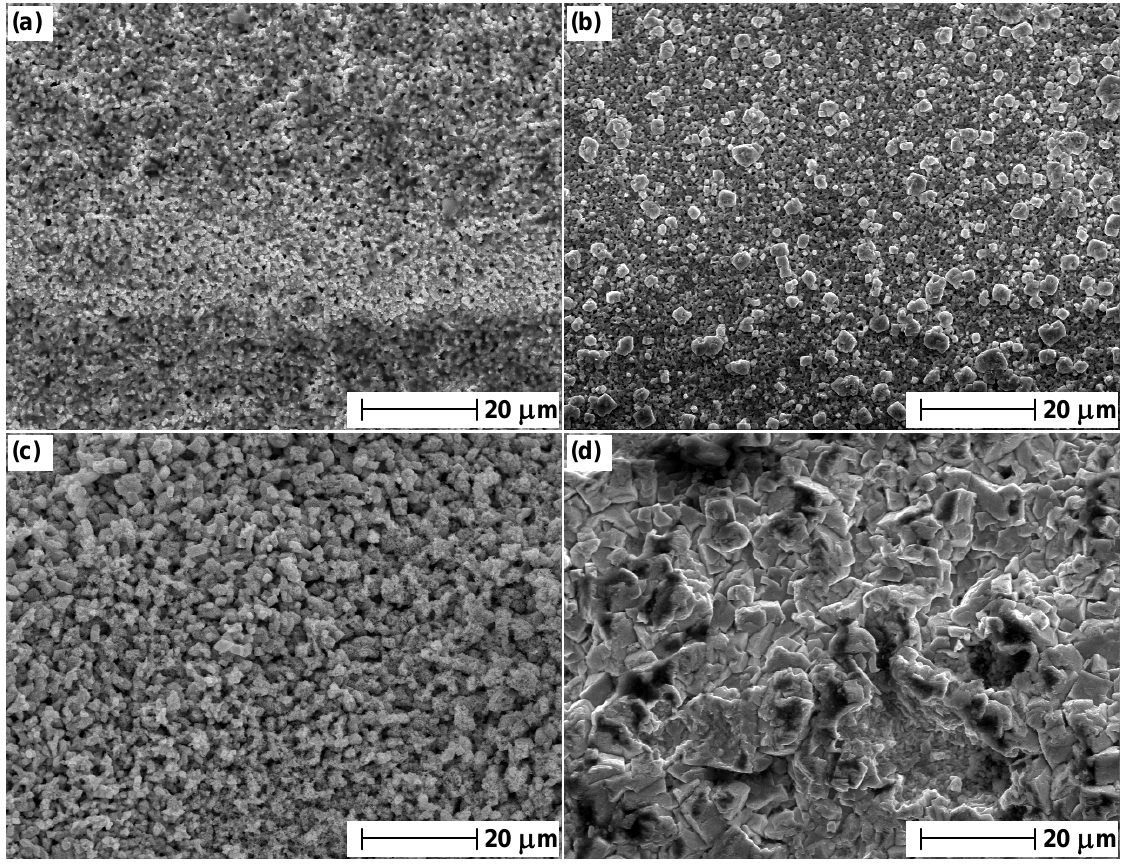
Figure 6. SEM images of Ag/AgCl produced by anodisation of Ag wire following a 2 hour annealing step in (a) air at 100  C, (b) air at 400  C, (c) nitrogen at 100  C and (d) nitrogen at 400 